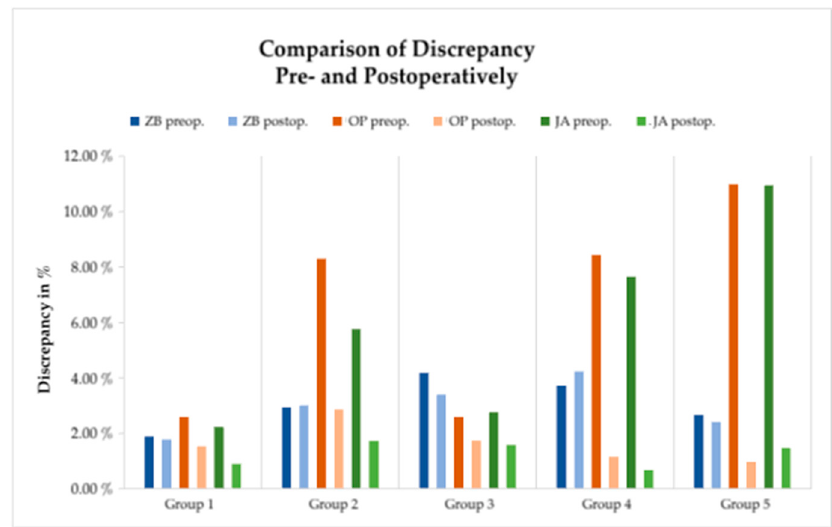
Figure 11. Comparison of pre- and postoperative discrepancy. Mean percentage discrepancy of facial left side versus right side at different levels (ZB = zygomatic bone (blue), OP = occlusal plane (red), and JA = jaw angle (green)) pre- and postoperative. Deviations on the level of zygomatic bone (blue) stay the same, while each group shows less deviation on the levels of occlusal plane (red) and jaw angle (green) after surgical treatment. Groups 4 and 5, in particular, show massively decreased discrepancy after surgical treatment.